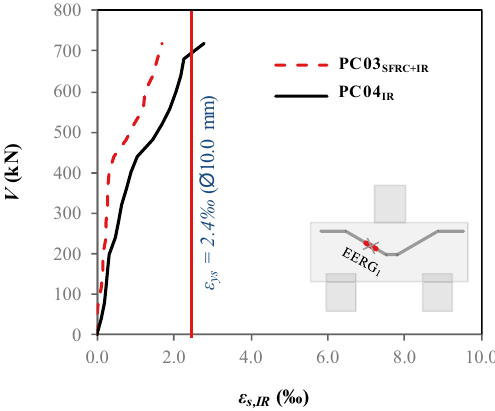
Figure 11. Load–strain ratio of the inclined reinforcements.